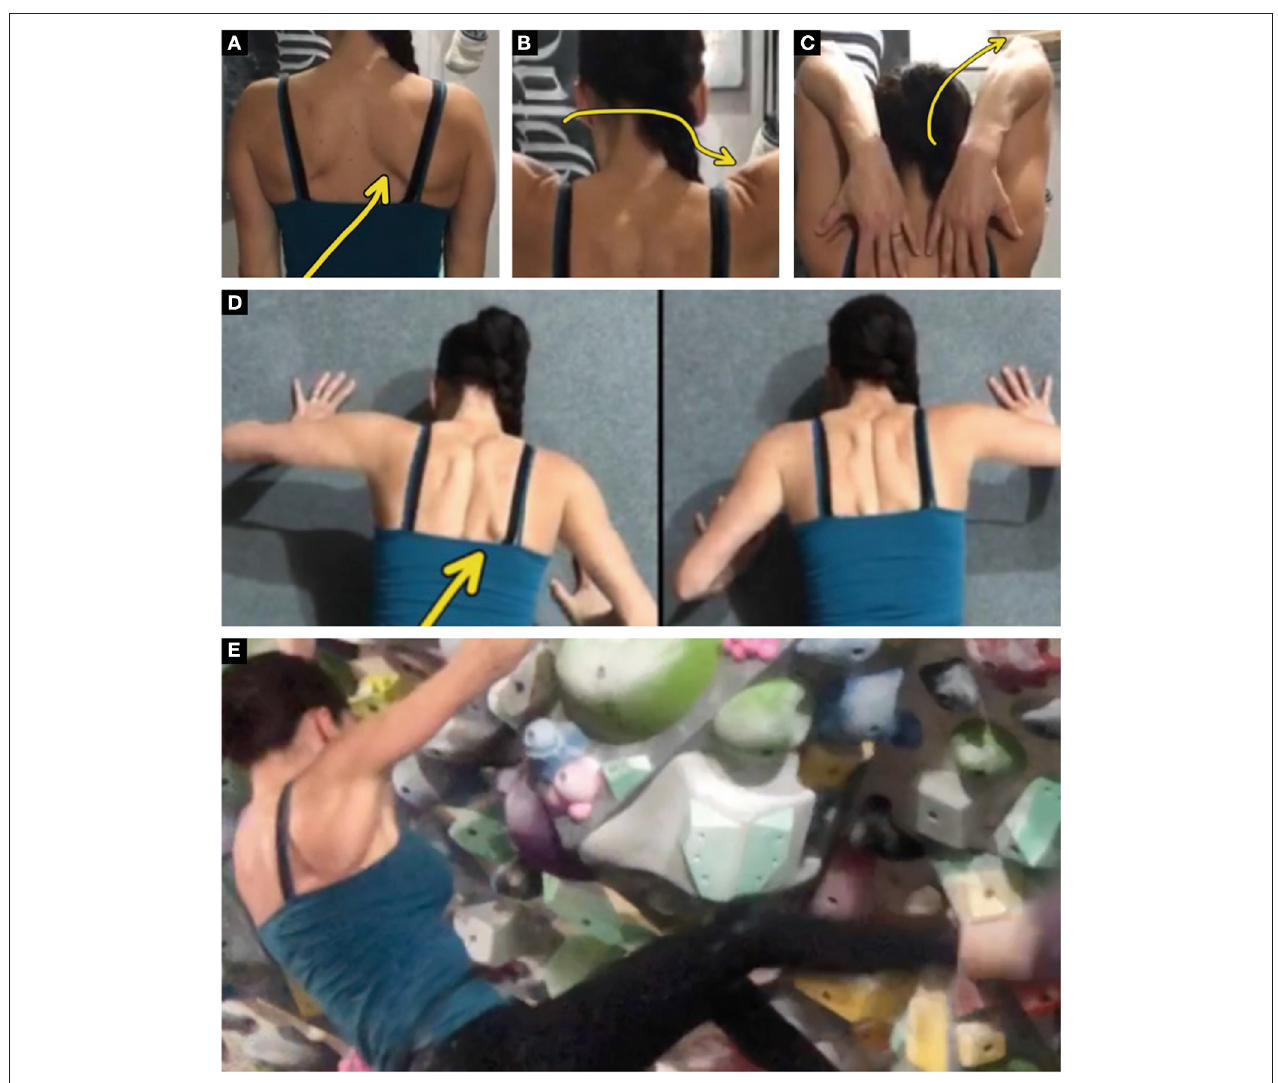
FIGURE 1 | (A) Winging of the inferior angle of the scapula right greater than left indicating serratus anterior weakness. (B) Increased right sided humeral creasing with shoulder abduction indicating possible humeral hypermobility and inadequate scapular upward rotation and elevation. (C) Right humeral internal rotation with shoulder/elbow flexion indicating a latissimus dorsi mobility deficit. (D) Right sided scapular winging with offset pushup indicating serratus anterior muscle weakness. (E) Scapular winging with climbing movement on overhung wall indicating serratus anterior muscle